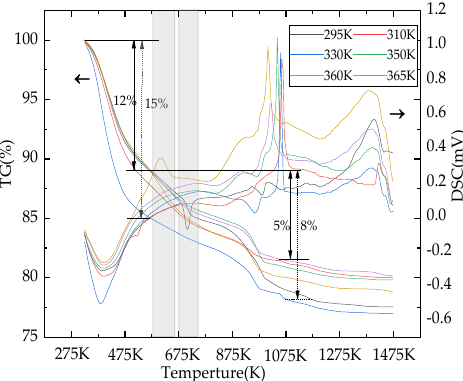
Figure 7. TG–DSC curves of the products at different